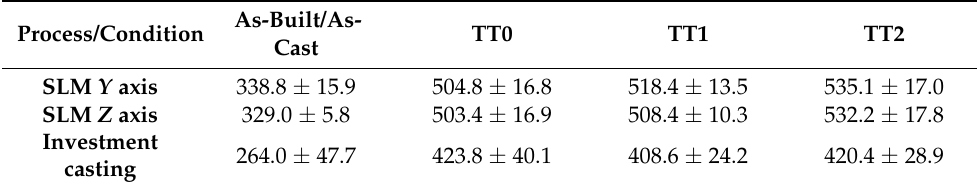
Figure 18. Engineering stress–strain curves for investment casting samples in different conditions. Hardness measurements were carried out according to the UNE-EN ISO 6507-1 stan- dard to complete the analysis of the mechanical properties. From these measurements, the average and standard deviation of the measurements were calculated, which are compiled in Table 7. Table 7. Hardness values obtained for analyzed